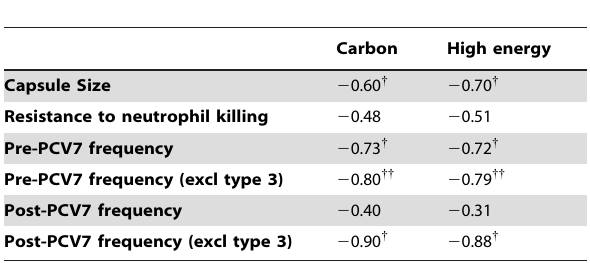
Table 1. Relationship between capsular polysaccharide composition, degree of encapsulation, neutrophil-mediated killing, and